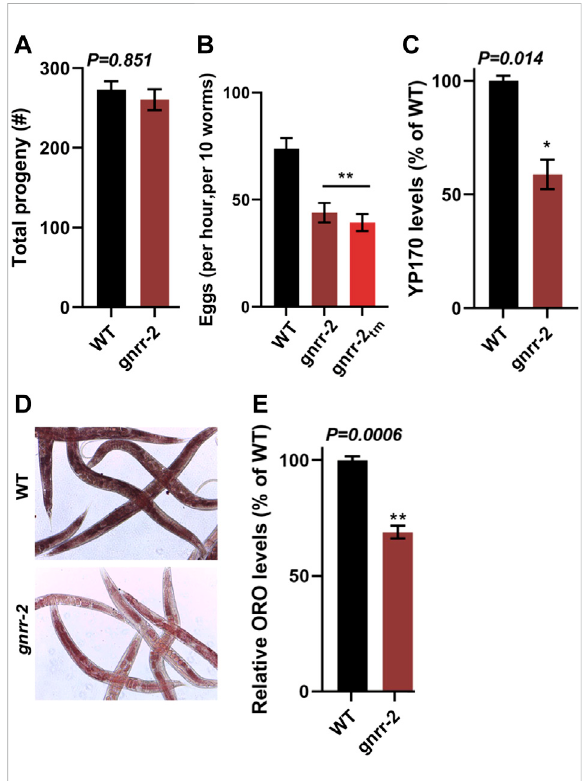
FIGURE 5 gnrr-2 modulates reproduction. (A) Brood size of WT and gnrr-2 animals. Progeny numbers were scored for age- synchronized fertile animals ( n ≥ 18). Data are means ±1 standard error of the mean (1 SE). Data were analyzed using the Wilcoxon Mann-Whitney rank sum test ( p = 0.851). (B) Egg-laying rates of WT, gnrr-2 , and gnrr-2 tm animals. The number of eggs laid by ten age-synchronized day two adult animals per hour ( N ≥ 11). Data are means ±1 standard error of the mean (1 SE). Data were analyzed using one-way ANOVA followed by a Tukey ’ s post-hoc test. (**) denotes p ≤ 0.001 compared with WT animals. (C) Vitellogenin levels in age-synchronized WT and gnrr-2 animals. Extracts of age-synchronized day two adult animals were separated on an SDS-PAGE gel and yolk protein (YP170) levels were quanti fi ed ( N = 4). Data are means ±1 standard error of the mean (1 SE). Data were analyzed using the Wilcoxon Mann- Whitneyranksumtest( p =0.014). (D,E) Representativeimagesand quanti fi cation of total fat stores in WT and gnrr-2 mutant animals. Total fat stores in age-synchronized day two adult animals were imaged using ORO staining (D) , and ORO levels of WT ( n = 60) or gnrr-2 ( n = 71) mutant animals were quanti fi ed from the images N = 3 (E) . Data are means ±1 standard error of the mean (1 SE). Data were analyzed using the Wilcoxon Mann-Whitney rank sum test ( p =